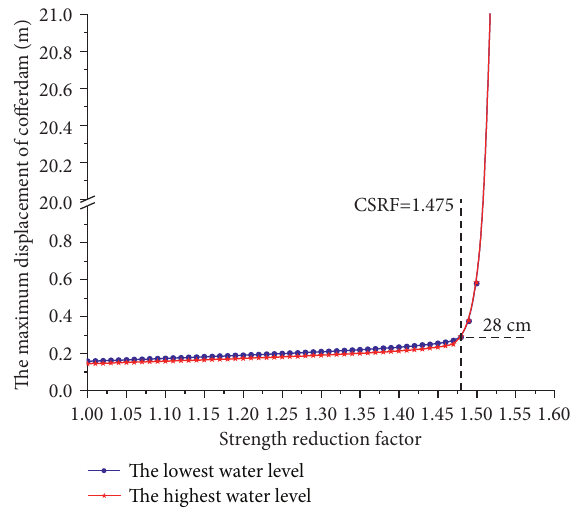
Figure 10: The variation law of the maximum displacement of the cofferdam with the strength reduction factor.